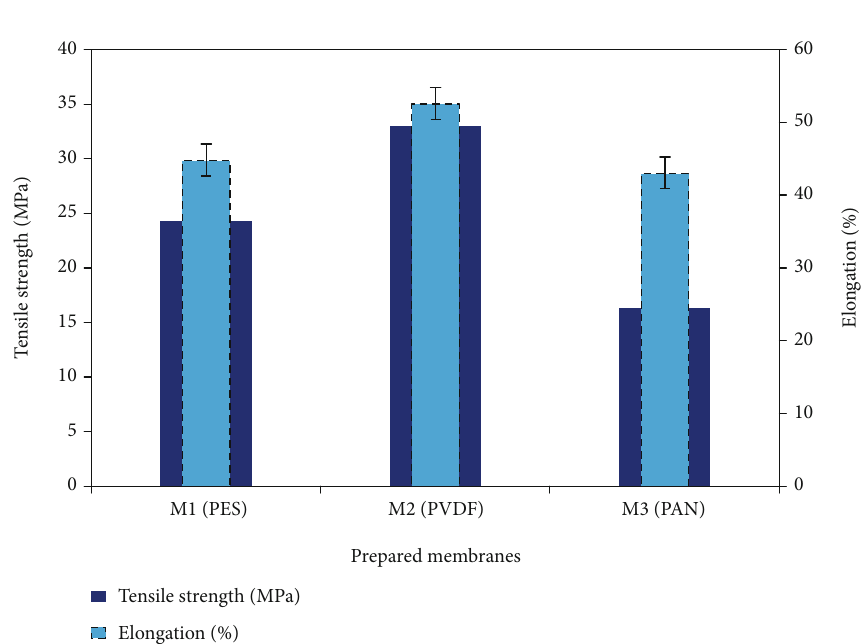
Figure 5: Mechanical properties of prepared